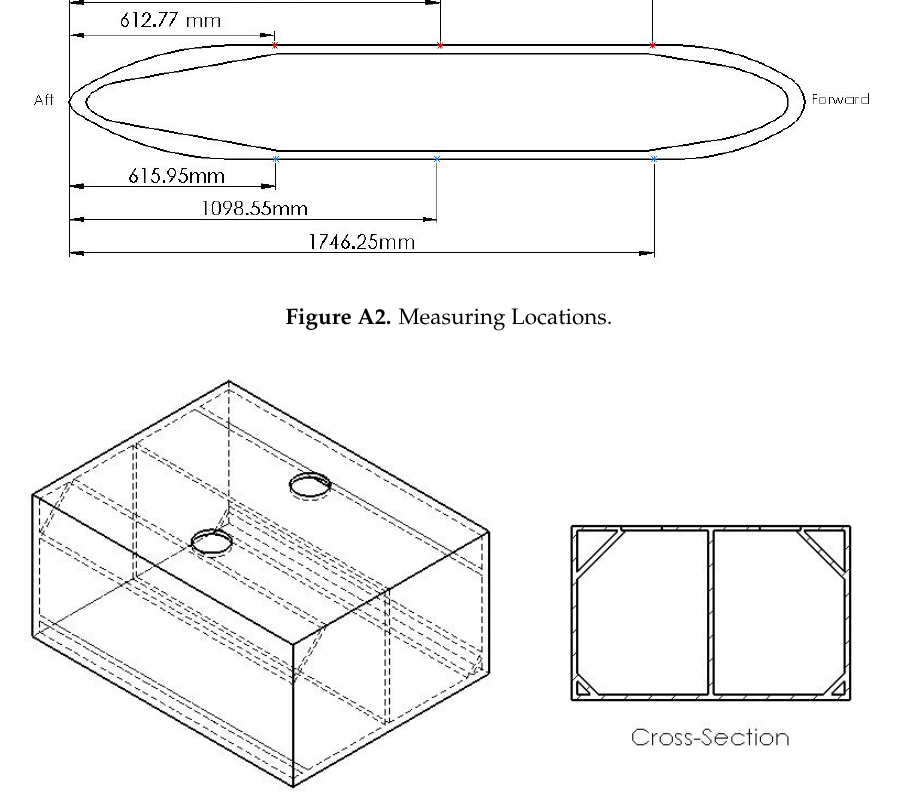
Figure A3. Schematic of Cargo